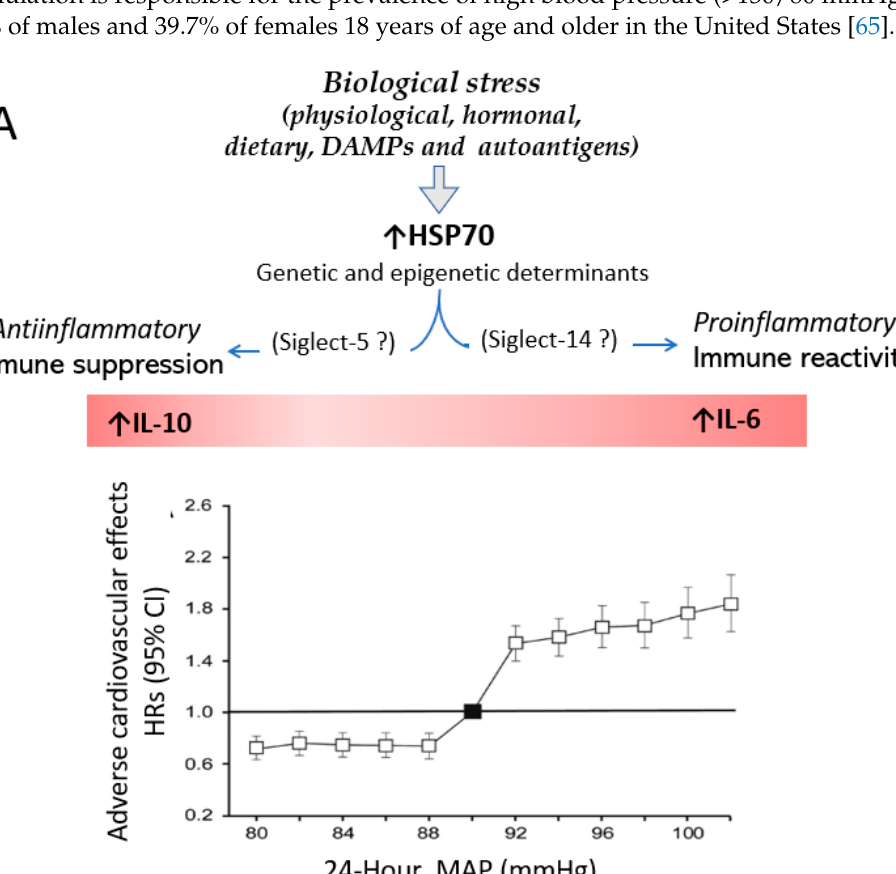
Figure 4. Stress-induced HSP70 overexpression and blood pressure. ( A ) We posit that biological stress induces overexpression of HSP70 that, depending on genetic and epigenetic determinants, induces or suppresses immune reactivity that drives or prevents hypertension. Adverse effects of hypertension are associated with inflammation. The potential role of interaction between HSP70 and Siglec-5 and Siglec-14 is discussed in the text. ( B ) Increased incidence of fatal and non-fatal cardiovascular outcomes is associated with 24 h mean arterial pressure of 92 mmHg or higher (Fig- ure 4B was published as Figure 1A in the open access paper of Melgarejo JD et al. [66]). In contrast with the stimulation of both innate and adaptive immunity in patients that develop severe hypertension, the remaining normotensive population responds to metabolic stress with a protective downregulation of inflammatory reactivity, which, as discussed earlier, is also a recognized HSP70 response to stress. The identification of ge- netic and epigenetic characteristics that determine the specific type of HSP70 response [67] and, perhaps, the differential engagement of Siglec-5 and Siglec-14, is critical in develop- ing strategies for controlling hypertension. 9. Conclusions There is considerable clinical evidence that associates stress, HSP70 and primary hy- pertension. Experimental data indicate that tubulointerstitial inflammation of the kidneys and salt-sensitive hypertension may be driven by immune reactivity to HSP70 and may be prevented and corrected by T-cell immunoregulatory responses that HSP70 may drive. The data on hypertension resemble the findings regarding other autoimmune diseases such as adjuvant arthritis in which disease activity is modulated by the induction of auto- reactive HSPs [23]. We suggest that genetic and epigenetic factors determine whether HSP70-driven autoimmune reactivity results in prohypertensive inflammation or a pro- tective anti-inflammatory response that prevents the development of hypertensive